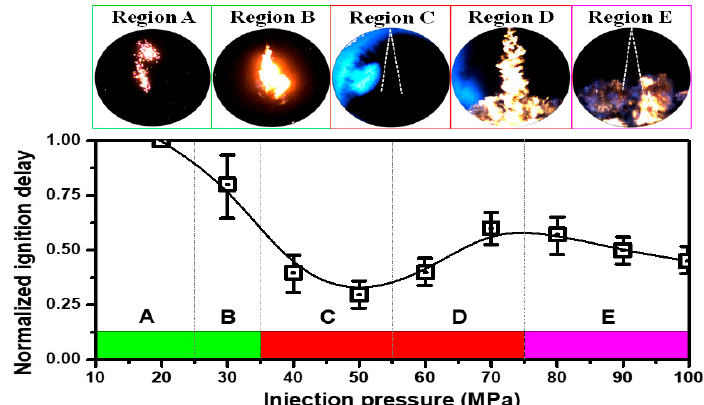
Figure 6. Correlations between normalized ignition delay time and injection pressure under different injection parameters and ambient conditions. The cases of P J = 20 MPa are taken as the